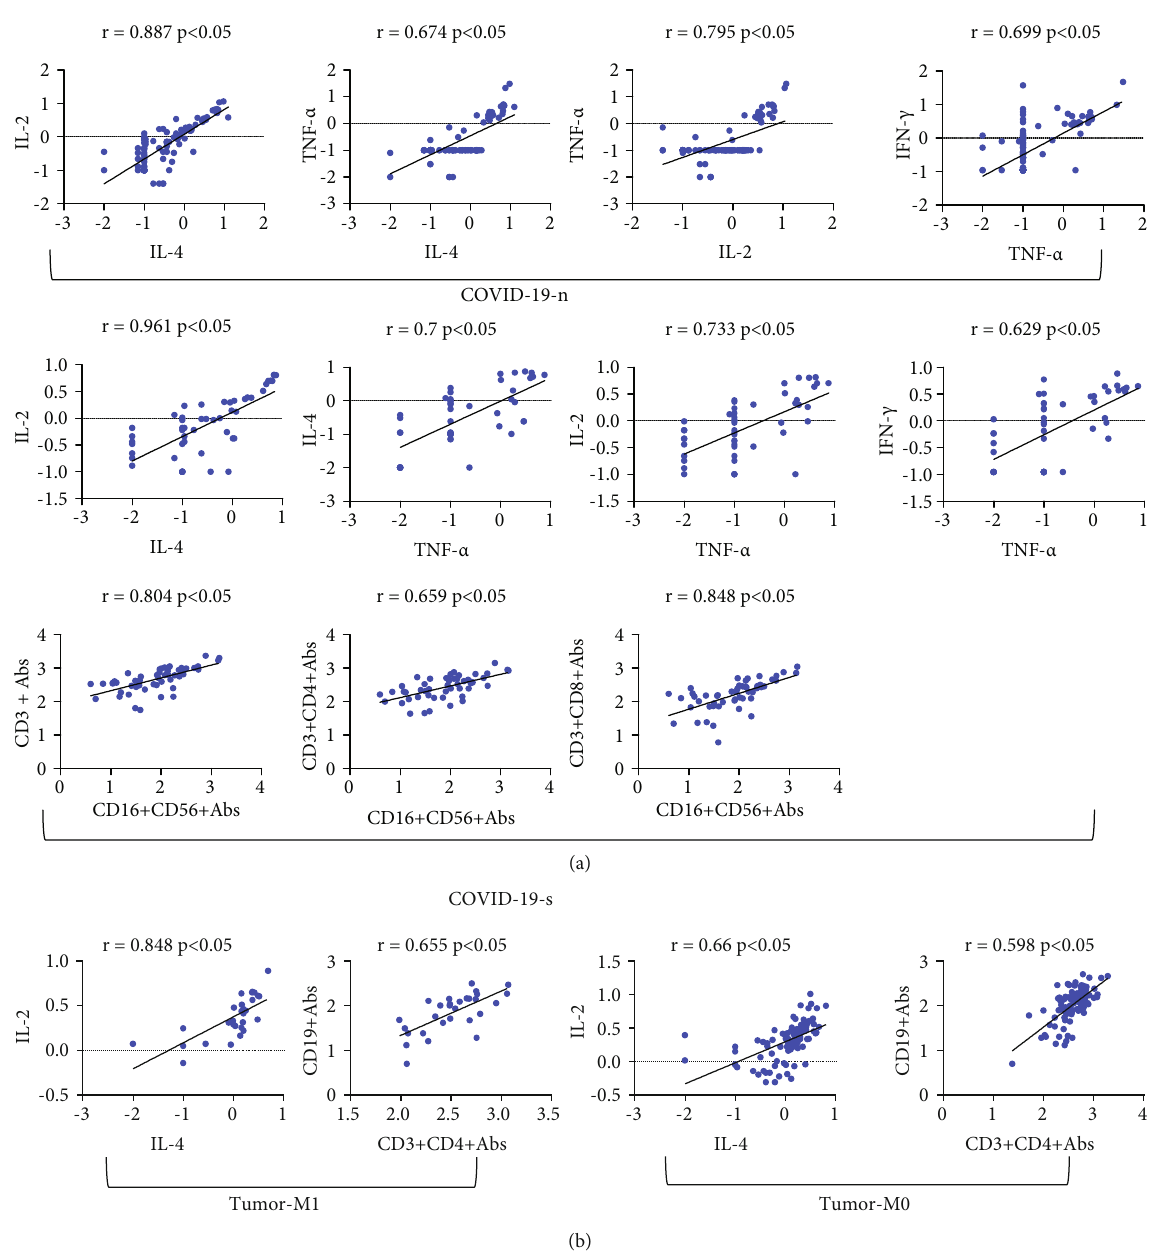
Figure 4: The correlation analysis of the four subgroups of patients with COVID-19 or cancer. (a) COVID-19 patients. (b) Cancer